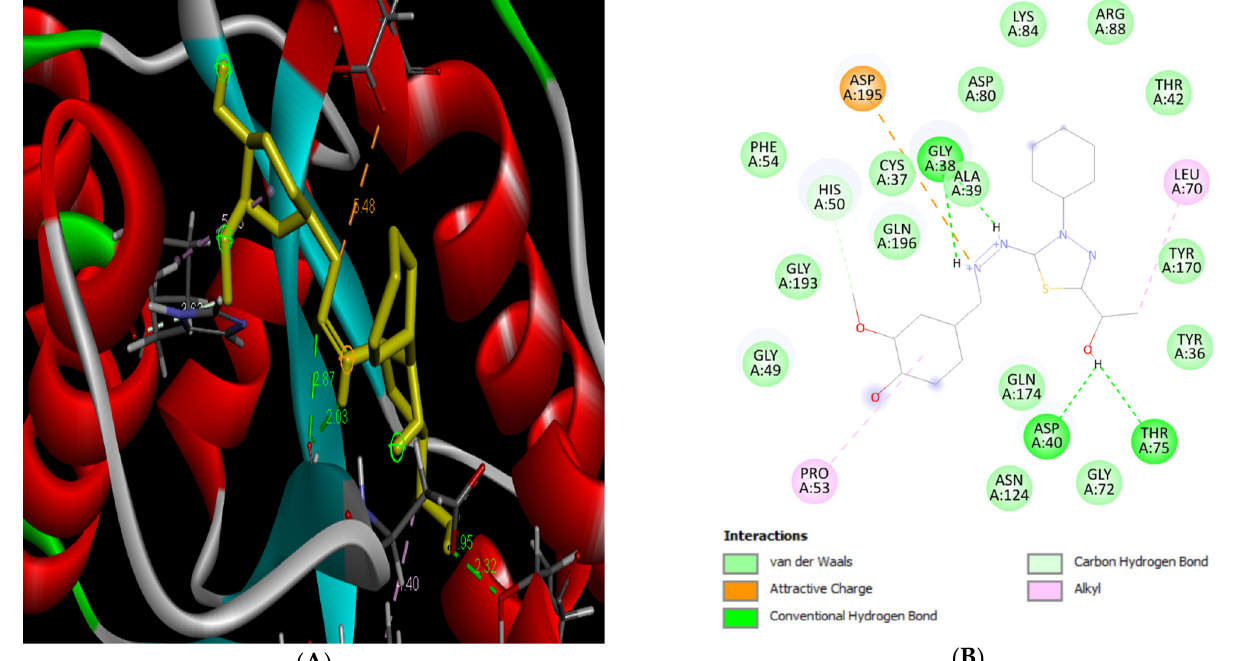
Figure 3. 2D ( B ) and 3D ( A ) representation of compound 4 docking with TyrRS.